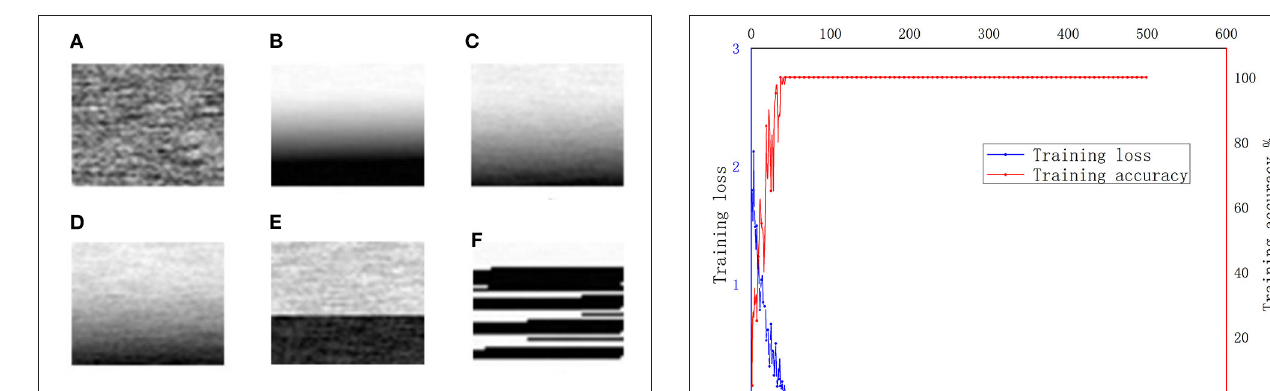
FIGURE 8 | Converted two-dimensional gray images of the gas sensor signals of six modes under a normal environment. (A) Normal signal; (B) The signal including heating wire disconnection (HWD) fault; (C) The signal including aging of the heating wire (AHW) fault; (D) The signal including aging of the sensitive body (ASB) fault; (E) The signal including exfoliation of the sensitive body (ESB) fault; (F) The signal including false welding of the sensitive body (FWSB) fault.